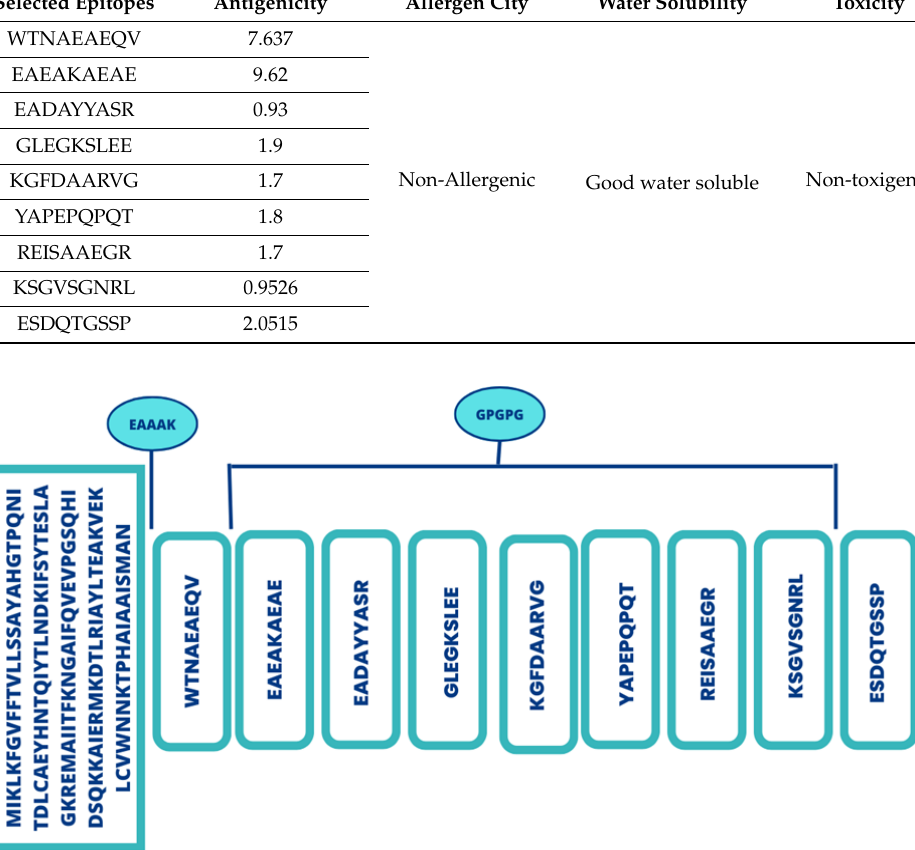
Figure 4. Schematic representation of multi-epitopes vaccine.